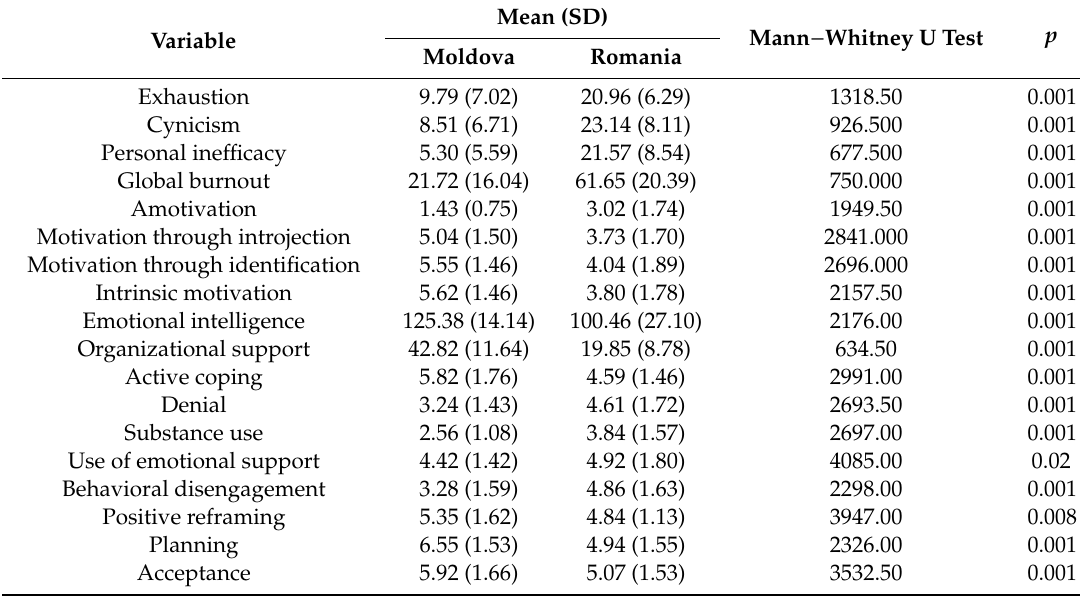
Table 1. Di ff erences between Moldavian and Romanian